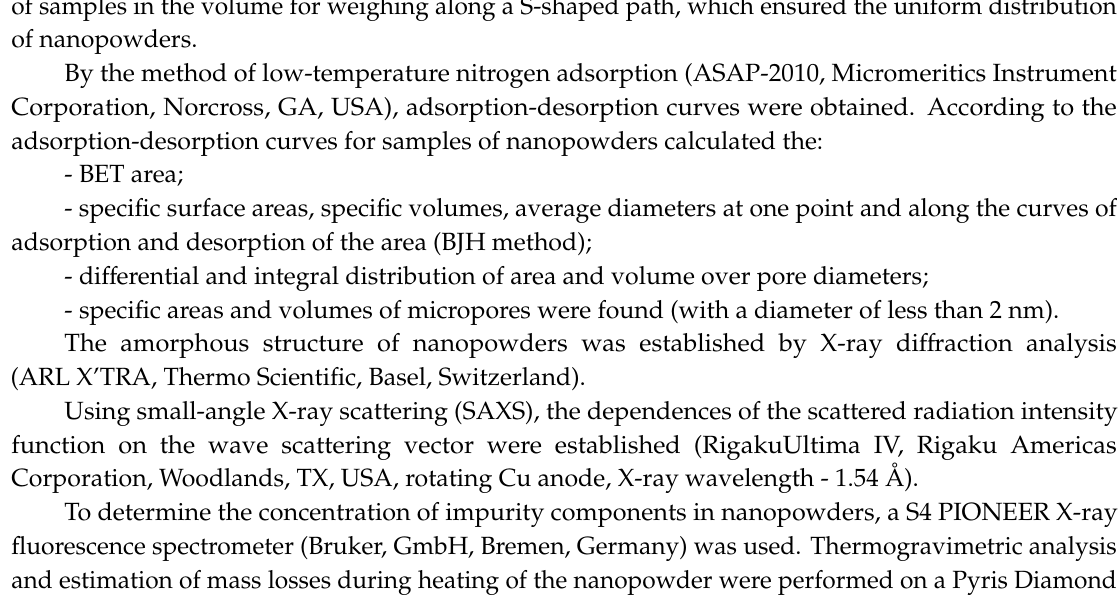
Figure 5. Dependence of temperature t in a vacuum chamber on the time of sublimation of cryogranules upon receipt of a nanopowder sample.